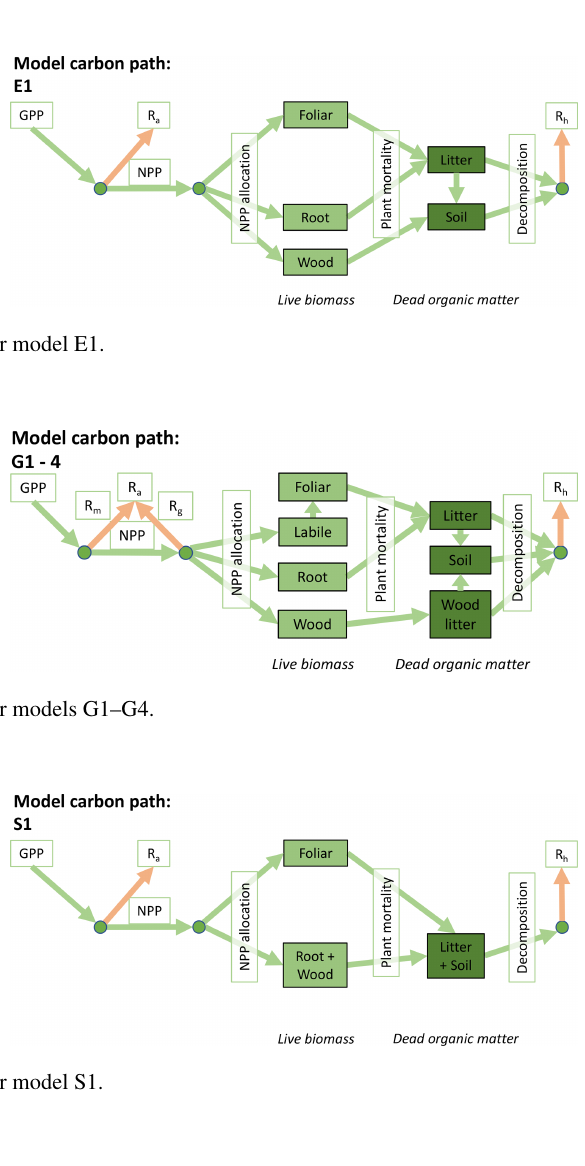
Figure B1. Carbon cycle structure for models C1–C8.